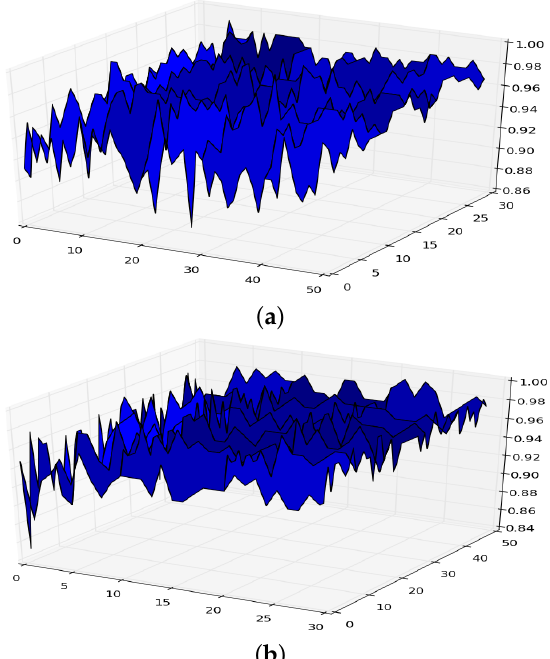
Figure 1. Surface of Φ λ , D for random forest. ( a ) Φ in RF. ( b ) Φ in RF.